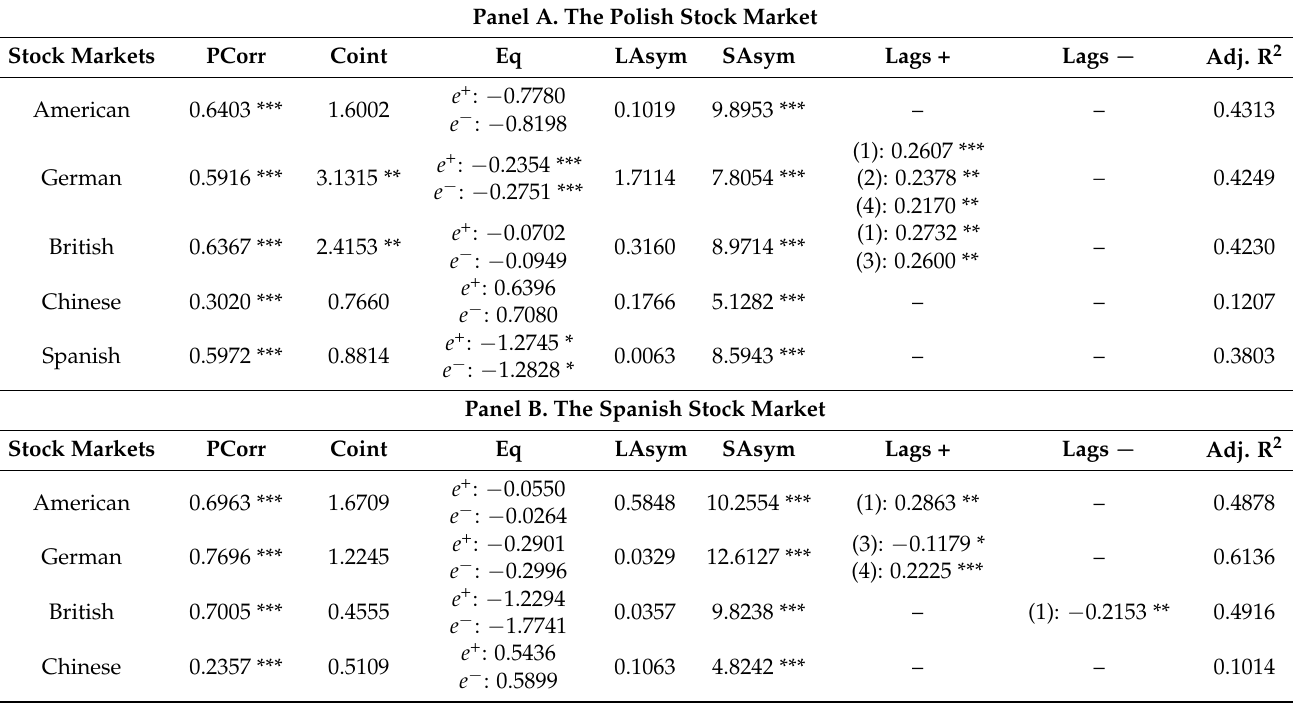
Table 4. Regression results of non-linear ARDL models: asymmetry and cointegration tests between the Polish (Panel A) and Spanish (Panel B) stock market and international (the American, German, British and Chinese) stock markets: the whole sample period